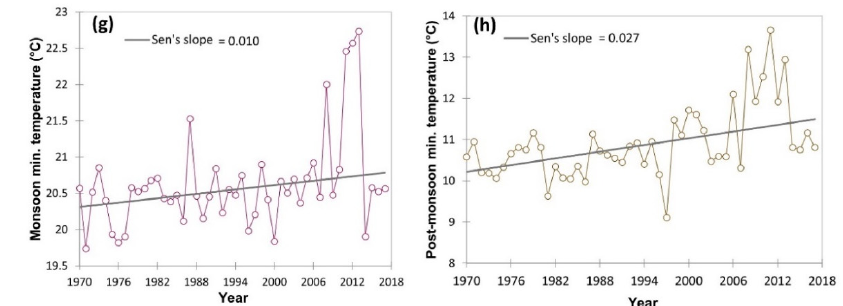
Figure 3. Time series trend analysis of different temperature (both maximum and minimum) attribute variation from 1970–2017 including four different seasons of the year using Mann–Kendall statistics and Sen’s slope. Here: ( a ) winter maximum temperature (°C); ( b ) pre-monsoon maximum temperature (°C); ( c ) monsoon maximum temperature (°C); ( d ) post-monsoon maximum temperature (°C); ( e ) winter minimum temperature (°C); (f) pre-monsoon minimum temperature (°C); ( g ) monsoon minimum temperature (°C); ( h ) post-monsoon minimum temperature (°C).